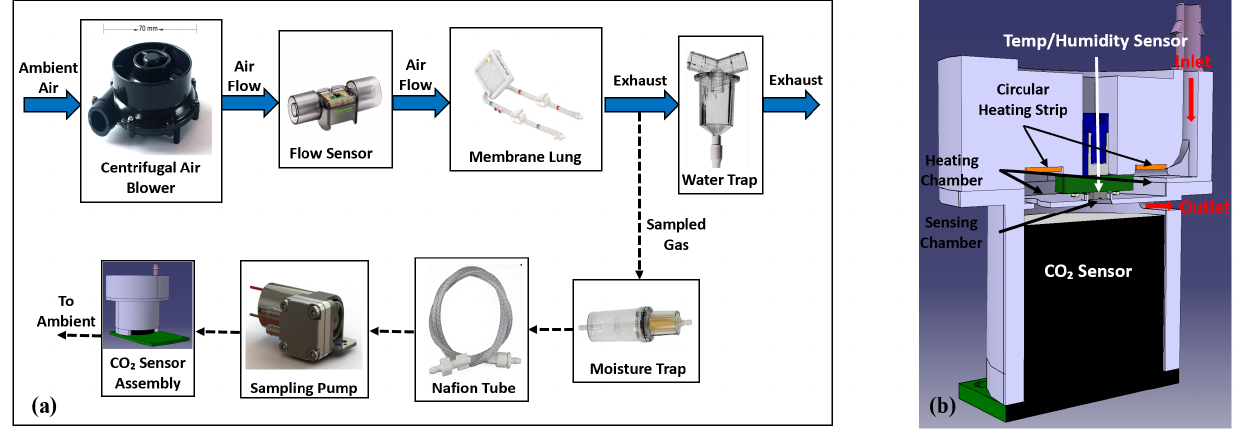
Figure 2. ( a ) Flow Diagram of servoregulator with images of major system components ( b ) Cut section view of the CO 2 sensor